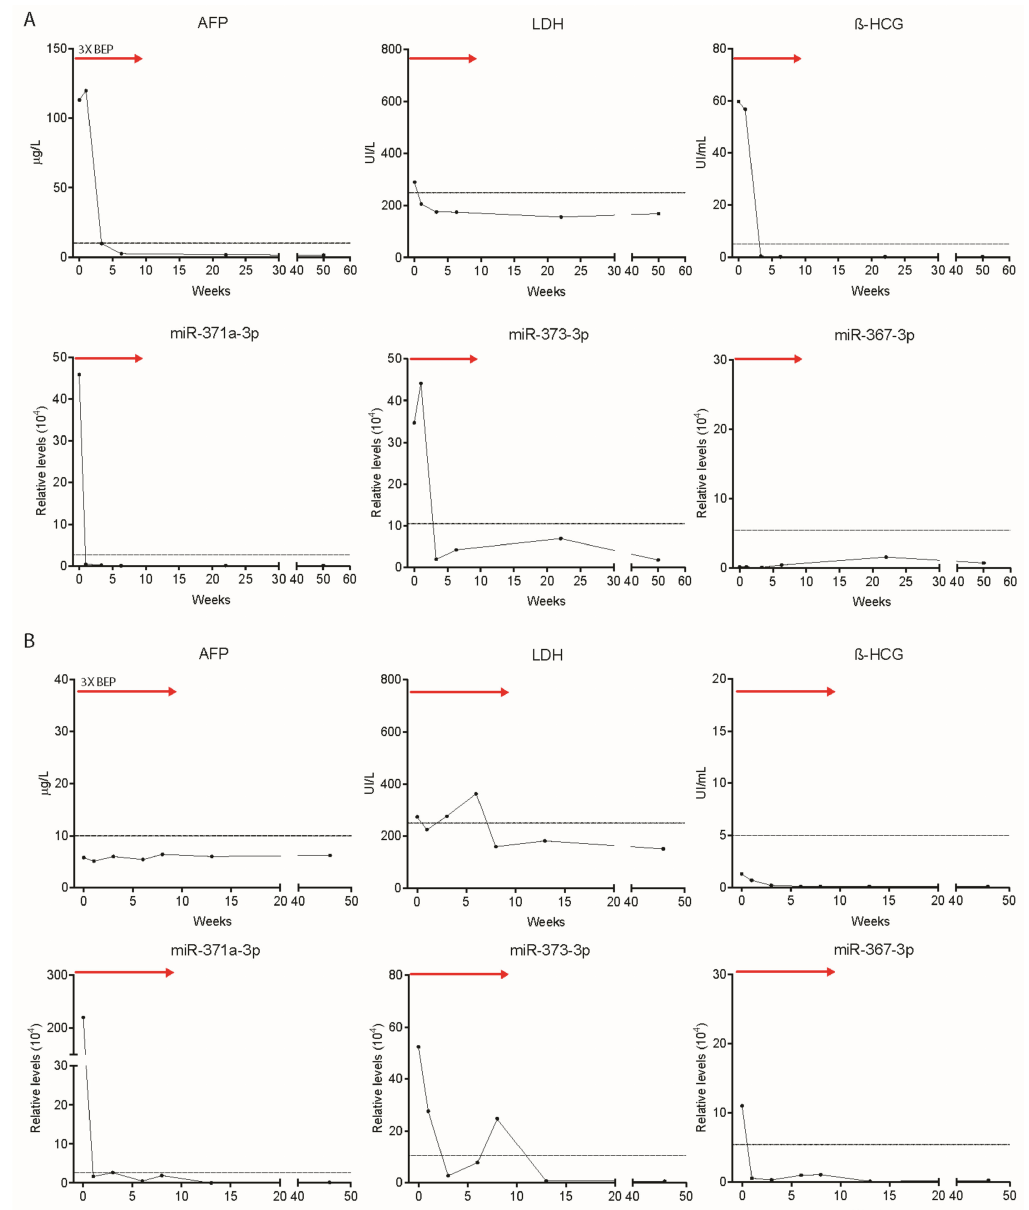
Figure 5. Levels of serum markers alpha-fetoprotein (AFP) ( µ g / L), LDH (UI / L) β -HCG (UI / mL) and relative levels of miR-371a-3p, miR-373-3p and miR-367-3p at start of chemotherapy, during treatment (red arrow) and follow-up of TGCC case 1 ( A ) and case 2 ( B ). Red arrows indicate chemotherapy duration (three courses of